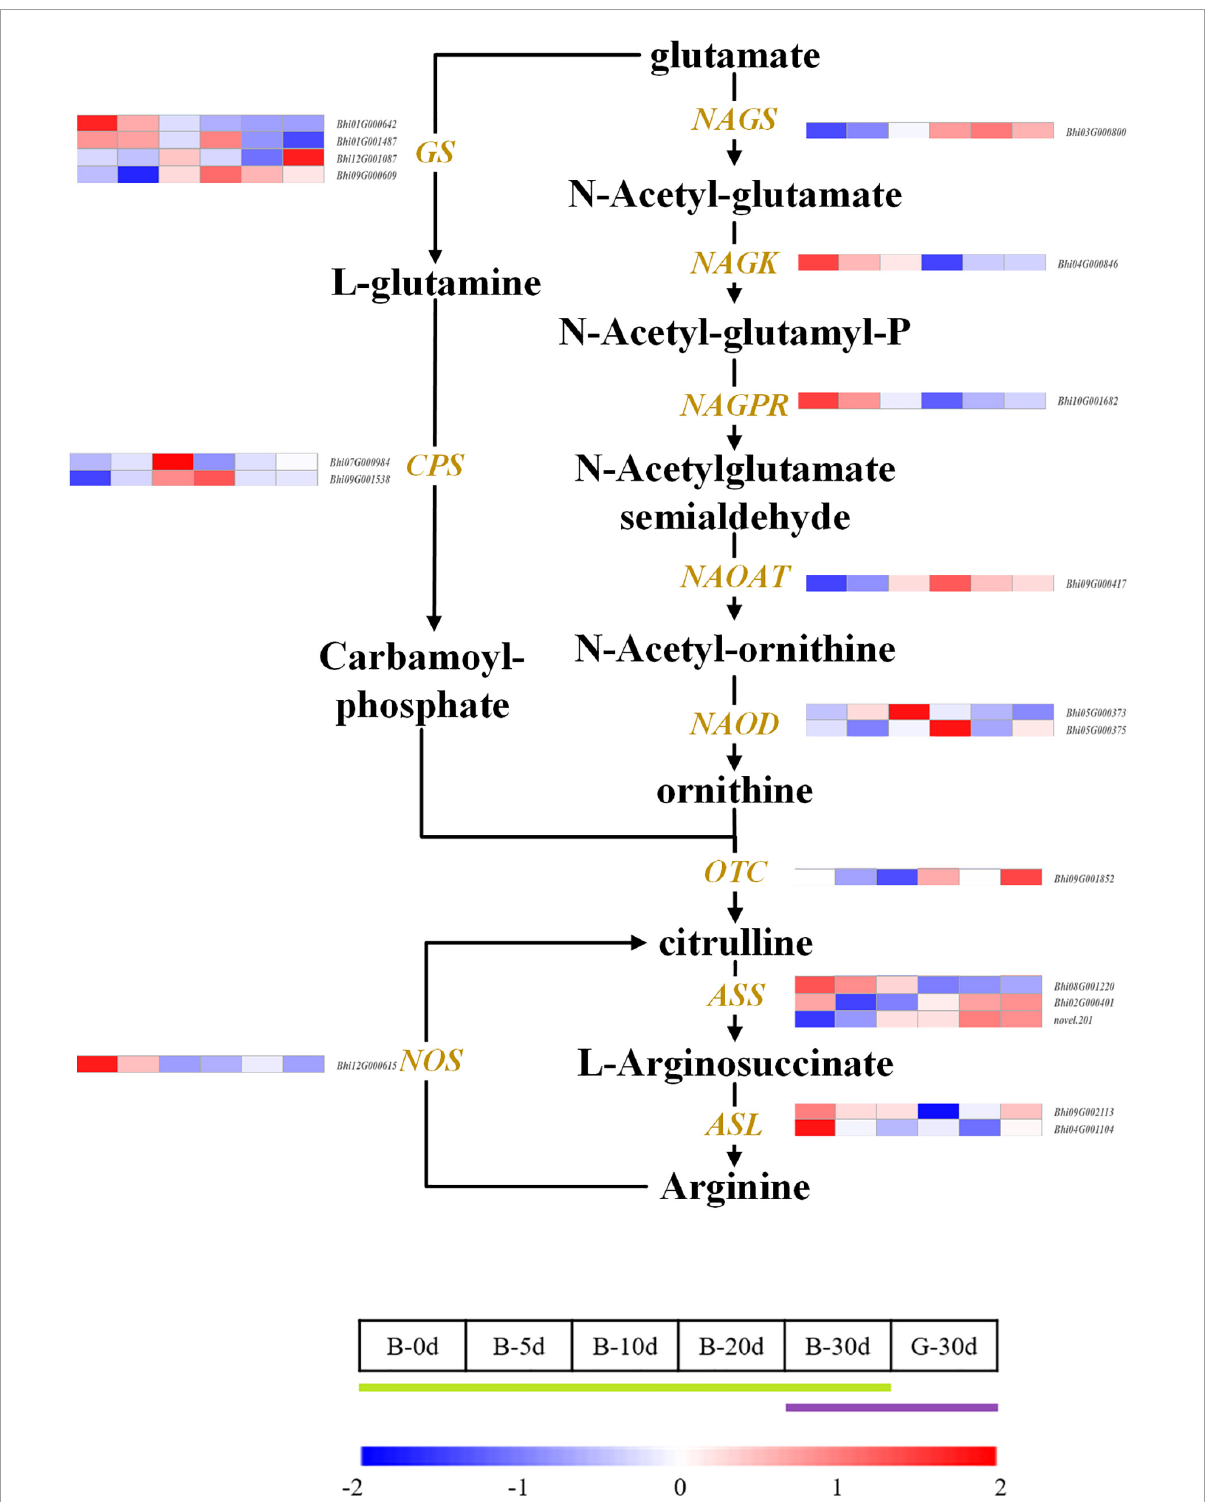
FIGURE7 Developmental expression profiles of genes of citrulline biosynthesis and catabolism in developing wax gourd fruit. NAGS : N -acetylglutamate synthase; NAGK: N -acetylglutamate kinase; NAGPR : N -acetylglutamatyl-5-P reductase; N AOAT: N -acetylornithine aminotransferase; NAOD : N -acetylornithine deacetylase; OTC : ornithine transcarbamylase; ASS : argininosuccinate synthase; ASL : argininosuccinate lyase; GS : glutamine synthetase; CPS : carbamoyl phosphate synthetase; NOS ; putative nitric-oxide